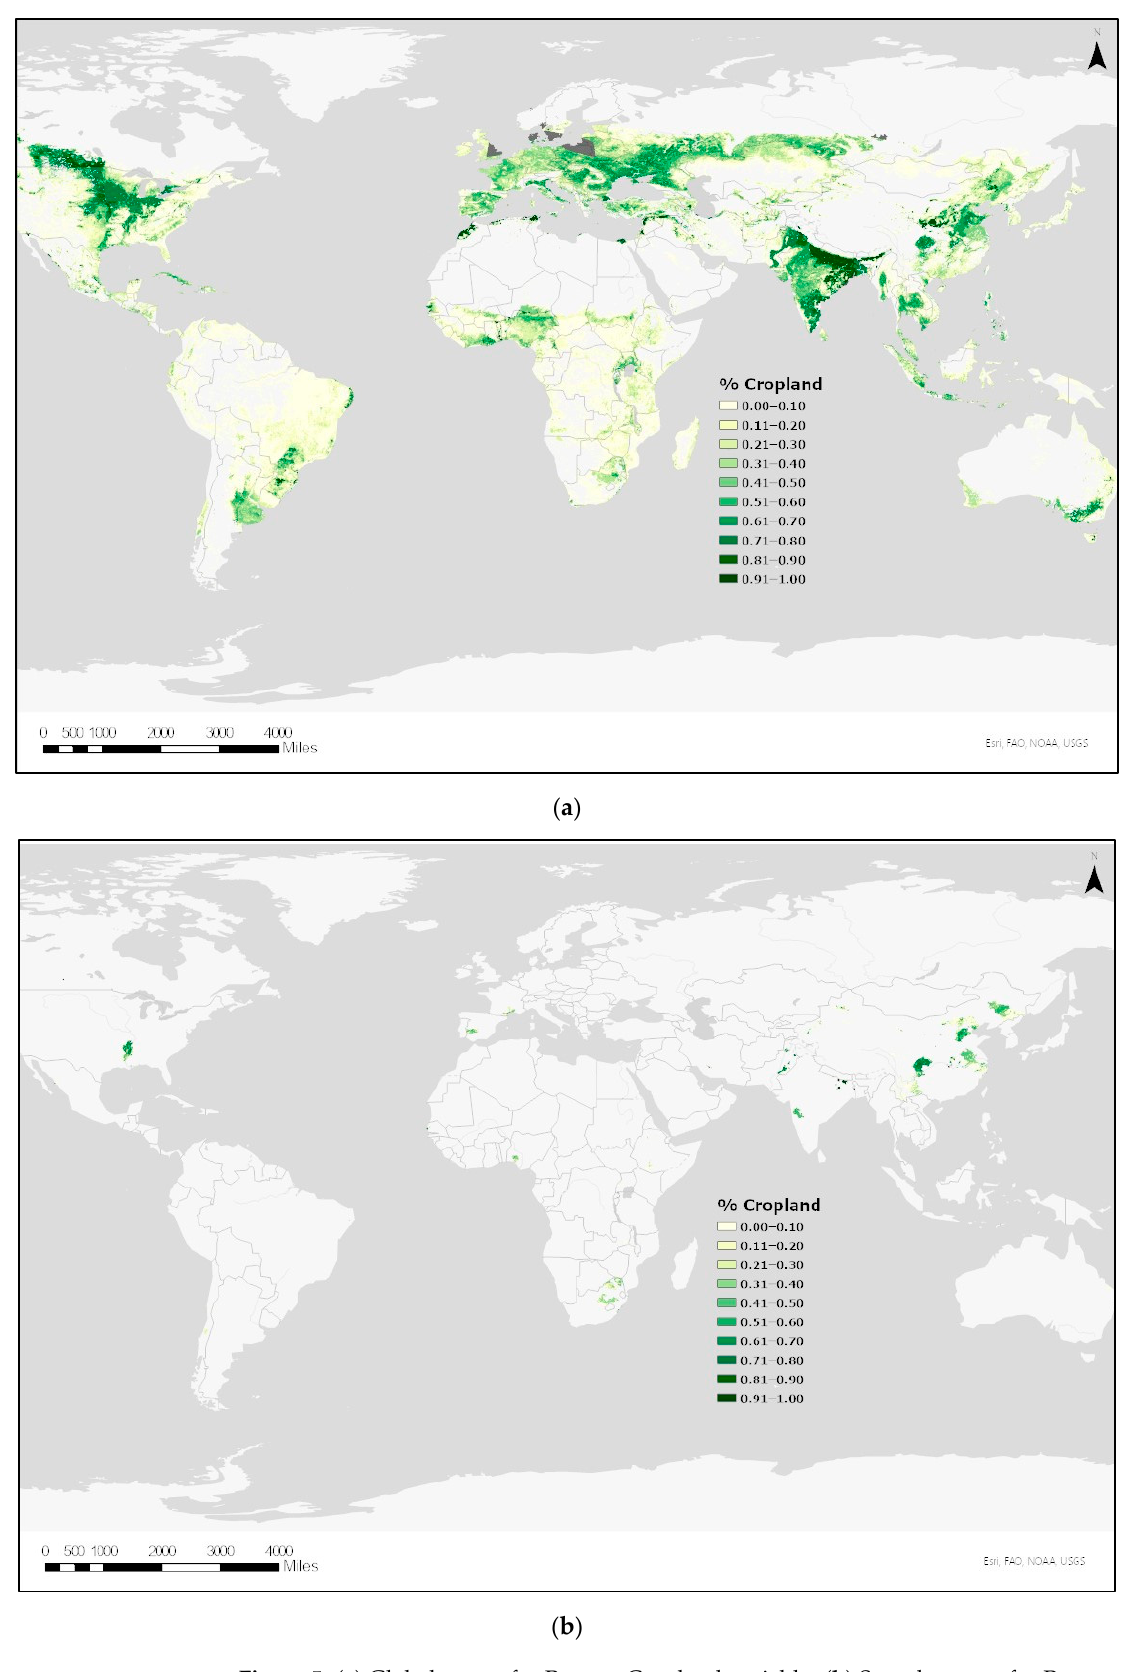
Figure 5. ( a ) Global extent for Percent Cropland variable. ( b ) Sample extent for Percent Cropland variable.